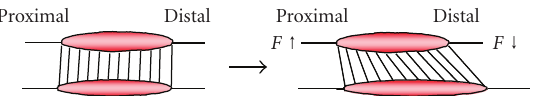
Figure 2: Schematic drawing to illustrate changes in the configu- ration of connective tissue between two muscles if one muscle is lengthened. Modified from Maas et al.